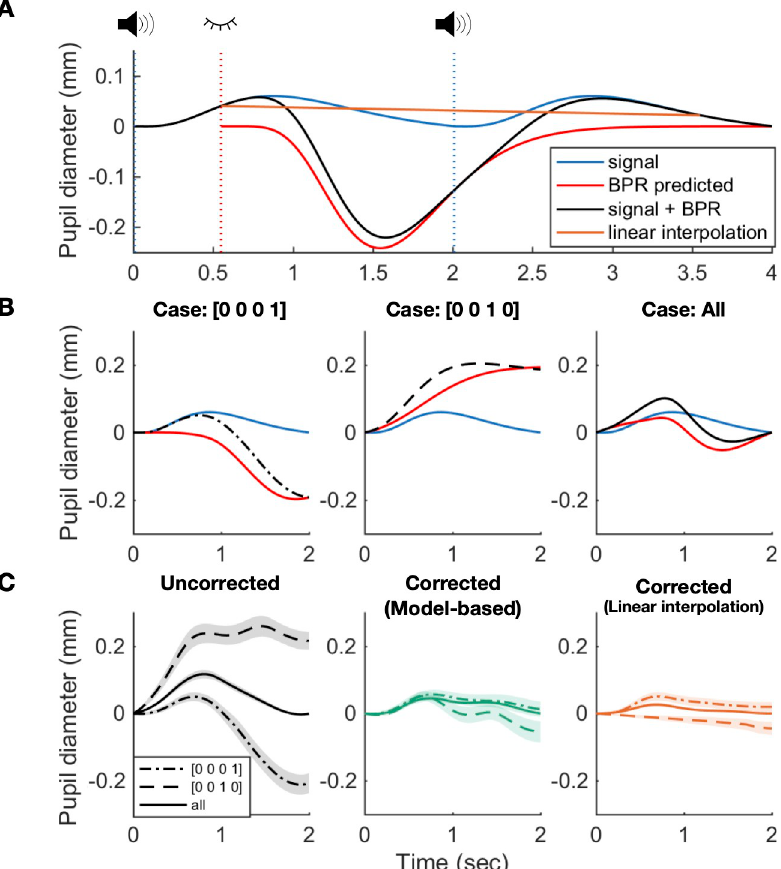
Fig 5. Temporal bias in blink patterns induces spurious distortion of pupil time course in the auditory oddball task. ( A ) Schematic example addressing how BPR confounds pupillometry in the auditory oddball task. The pupil dilates by an auditory tone, which is the signal experimenters are interested in (blue). However, subjects spontaneously blink during the experiment, and it evokes BPR (red). Subjects tend to frequently blink about 500 ms after the stimulus (shown in Fig 3B). Therefore, BPR would distort the pupil response to the stimulus by decreasing it during the trial in which blink occurred and by increasing it during the subsequent trial. Linear interpolation of 3 s after a blink (orange) slightly reduced the pupil response in this case. ( B ) Simulation of pupil time course shape by BPR. BPR would induce significant and spurious distortion in shape. To identify the spurious distortion pattern by BPR clearly, two cases were selected. The cases where a blink occurred at the current trial (left panel) or right before the trial (middle panel) are shown (see Materials and Methods for details). The observed pupil time course (black) would be the sum of the pupil response to cognitive state (blue) and BPR (red). Note that it has increased and decreased by BPR (red) as shown in A. (right panel) In all trials, the increasing and decreasing effects are combined and happened such that predicted mean profile of pupil-size measurements (blue) so somewhat exaggerated the peak of the pupil dilation. ( C ) The spurious distortion in shape was identified as anticipated and fixed by the correction method. (Left panel) Pre-correction pupil time courses (black). When a blink occurred, the spurious decrease in the blink-occurred trials (dash-dotted line), the spurious increase in the post-blink trials (dashed line), and the spurious increase for the first 1 s and the following decrease in all trials (solid line) were observed as anticipated by the generative model. (Middle panel) Most of these spurious distortions were removed or attenuated after applying the model-based BPR correction method (green). (Right panel) The spurious distortions were over-corrected after applying the 3-s long linear interpolation correction method such that the all-trial average profiles of pupil-size measurements was substantially reduced (orange). Line and shade indicate the mean and standard errors of the mean (SEM) across subjects,